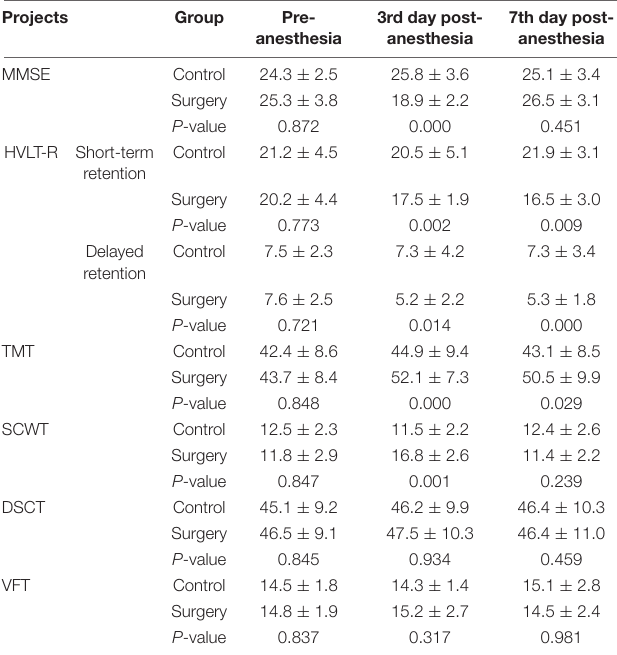
TABLE 4 | The incidence of POCD between the two groups (n).